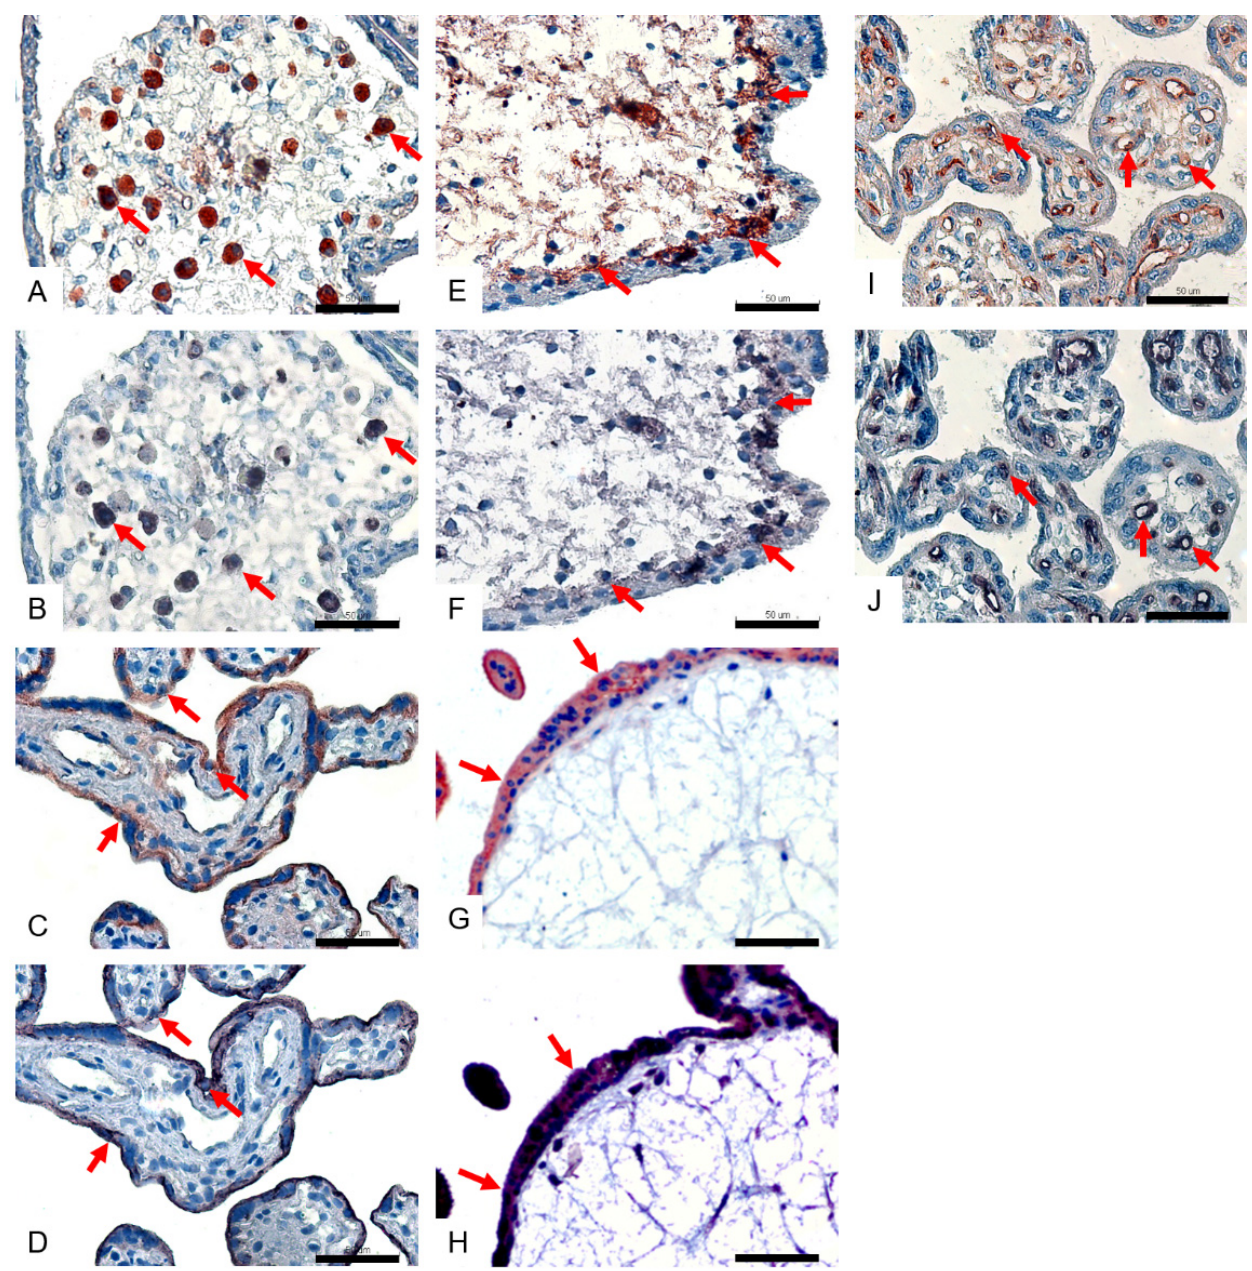
Figure 3. Confirmation of lectin-positive cell types by special IHC in a human placenta. Brown and brown–red colors stand for the positive signals in the lectin staining ( A , C , E , G , I ), and the purple– black color stands for positive signals in cell marker immunohistochemistry ( B , D , F , H , J ). In the Stain–Decolorize–Stain (SDS) method, the macrophages (red arrow) were positive for SNA ( A ) and CD68 (macrophage marker) ( B ); the syncytiotrophoblasts (black arrow) were positive for MAA I ( C ) and PLAP (syncytiotrophoblast marker) ( D ); the cytotrophoblasts (red arrow) were positive for MAA II ( E ) and E-cadherin (cytotrophoblast marker) ( F ); in consecutive sections, the syncytiotrophoblasts (red arrow) were positive for MAA I ( G ) and PLAP (syncytiotrophoblast marker) ( H ); the vascular endothelial cells (black arrow) were positive for MAA II (I) and CD34 (vascular endothelial cell marker) ( J ). All sections were counterstained with hematoxylin. Scale bar = 50 μ m.